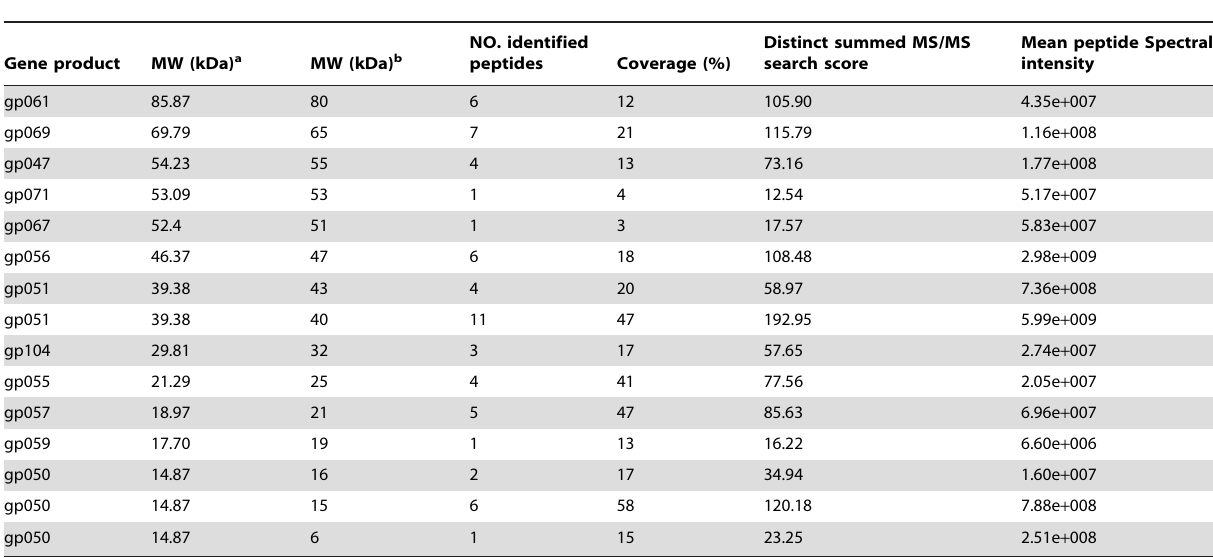
Table 4. Mass spectrometry identification of PaP1 structural